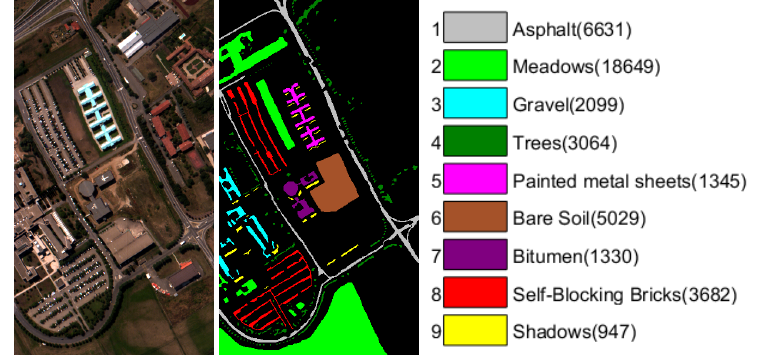
Figure 1. The false color composition and ground truth of Pavia University data with numbers of samples for each class in